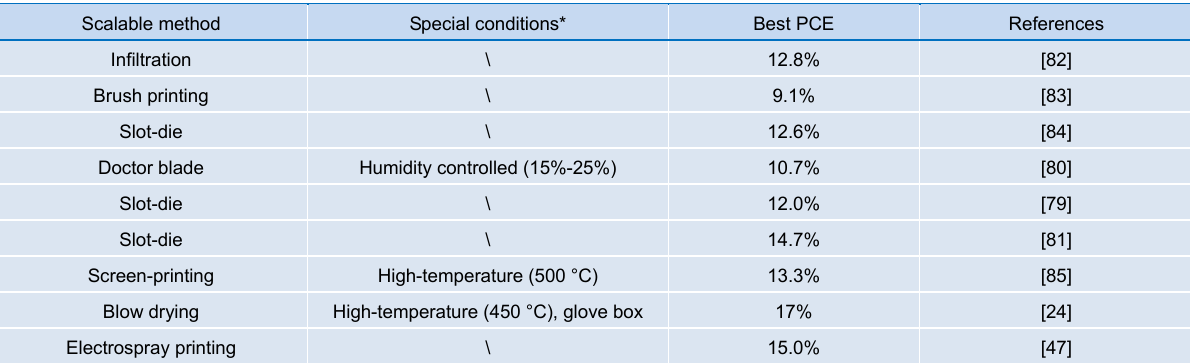
Table 2 | Overview of PCE of the reported PSCs with all three layers (ETL, perovskite, and HTL) fabricated using scalable method 47 . Scalable